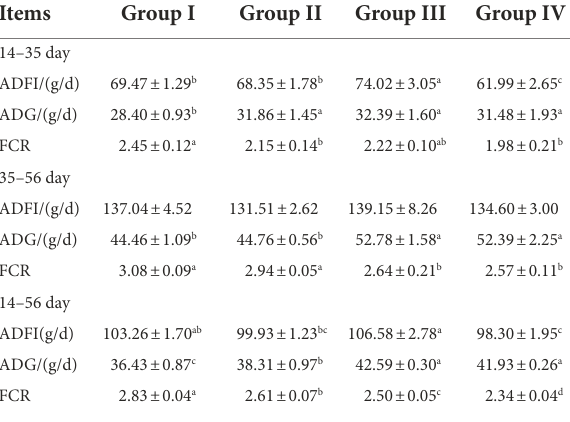
TABLE 6 Effects of different levels of FGSM on serum biochemical.